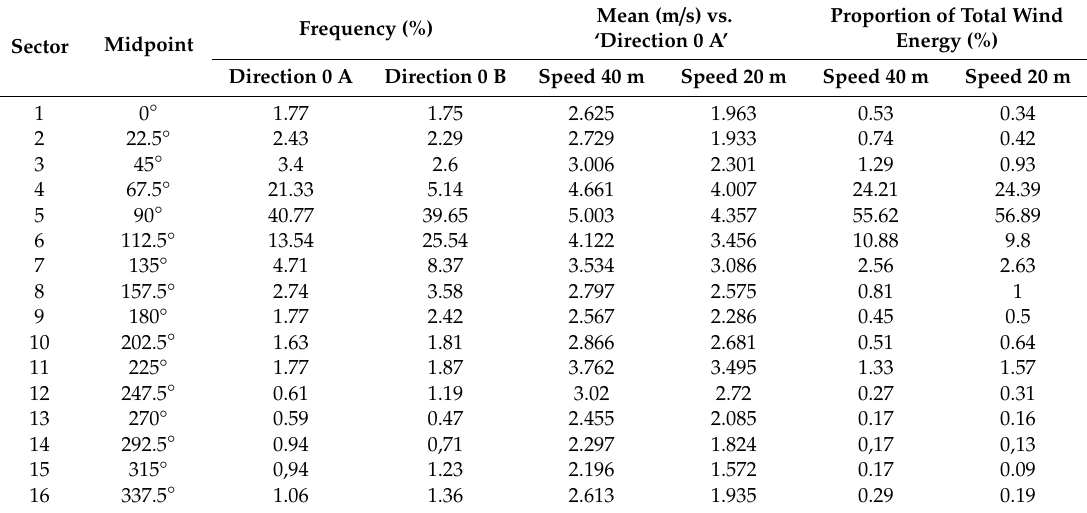
Figure 9. Wind direction as a function of mean speed. Source: generated by the software. Table 3. Mean wind speed, frequency, and energy as function of direction. Source: the